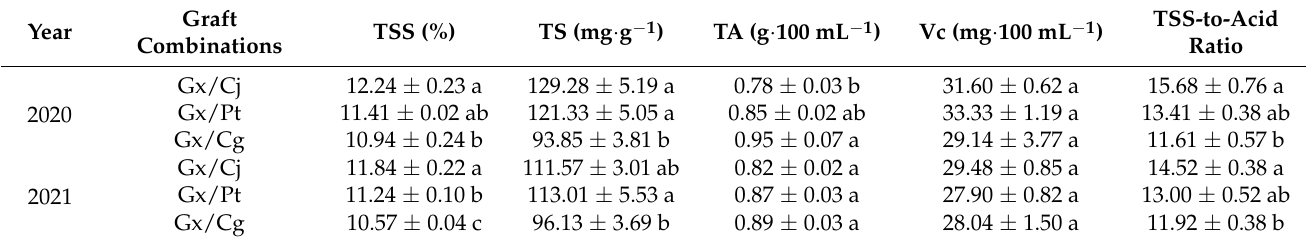
Table 2. Effect of different rootstocks on the fruit quality of ‘Guanxi Miyou’.